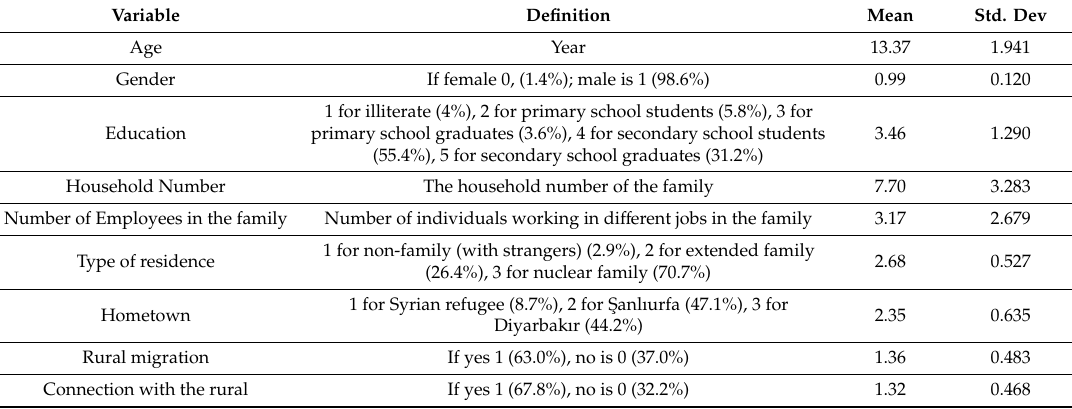
Table 1. The descriptive statistics of the